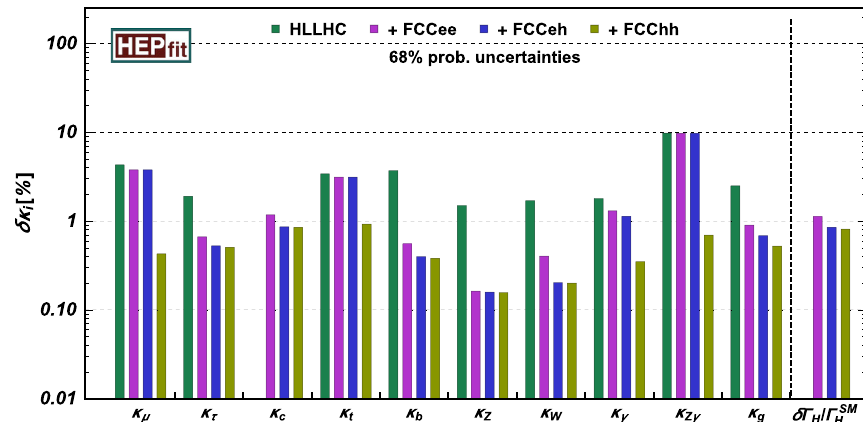
Fig. 8.5 One-sigma precision reach at the FCC on the different coupling scaling factors for each SM particle, within the κ -framework. For the HL-LHC fit the Higgs width is assumed to be SM-like and also κ c = 1 is set. All the other fits are performed lifting these restrictions, thus allowing for possible extra contributions to the Higgs width. The precision on (cid:7) H is also shown in these